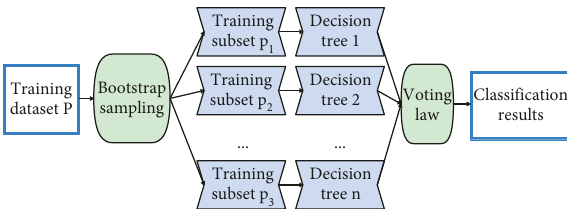
Figure 3: Training classification of the random forest algorithm.